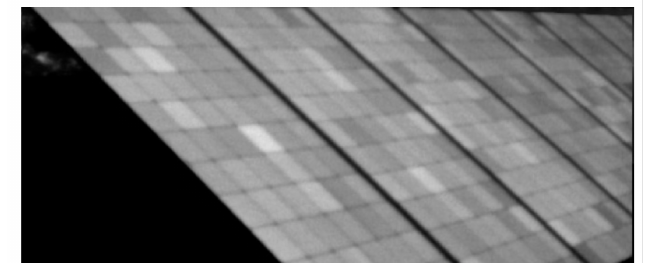
Figure 17. The electroluminescence (EL) of the testbed.